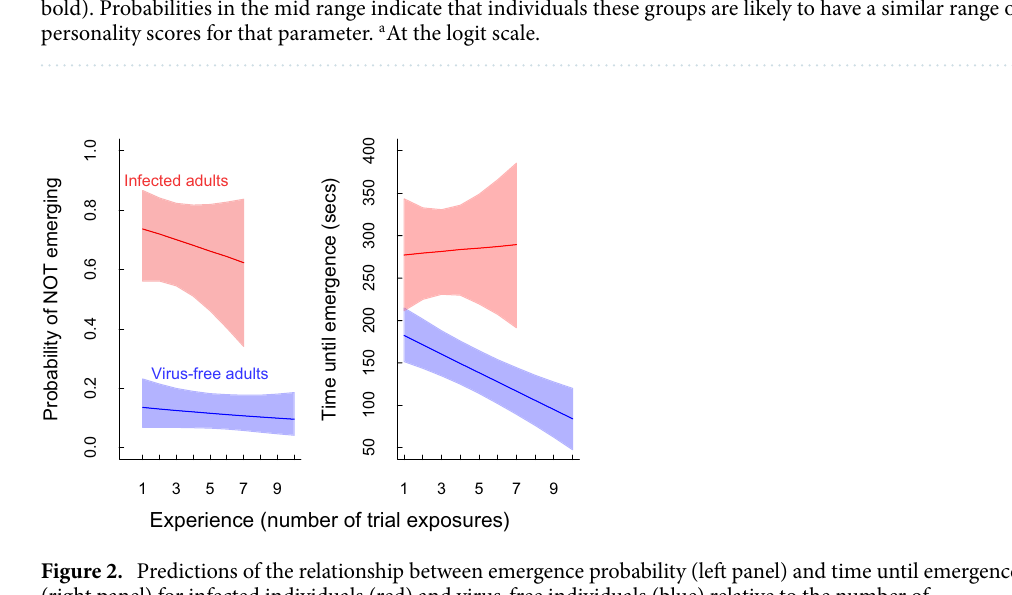
Figure 2. Predictions of the relationship between emergence probability (left panel) and time until emergence (right panel) for infected individuals (red) and virus-free individuals (blue) relative to the number of experimental trials an individual has experienced. Lines are means and shaded areas are 95% CIs as produced by our Bayesian hurdle